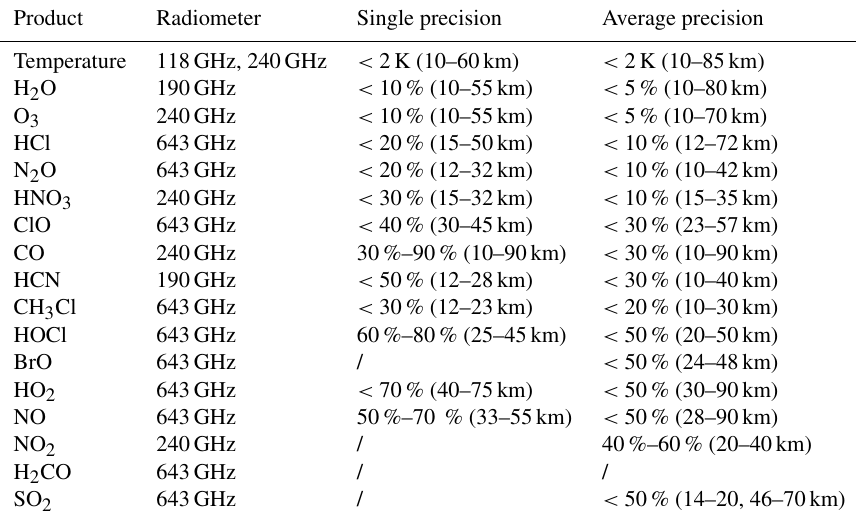
Figure 28. Simulation result of SO 2 retrieval using 659GHz lines. “Single” and “Average” represent the retrieval error using different noise. “Profile” represents the typical profile used in the simulation. The black solid line in the last panel represents the FWHM (i.e. vertical resolution). Table 3. Simulation results of TALIS retrieval